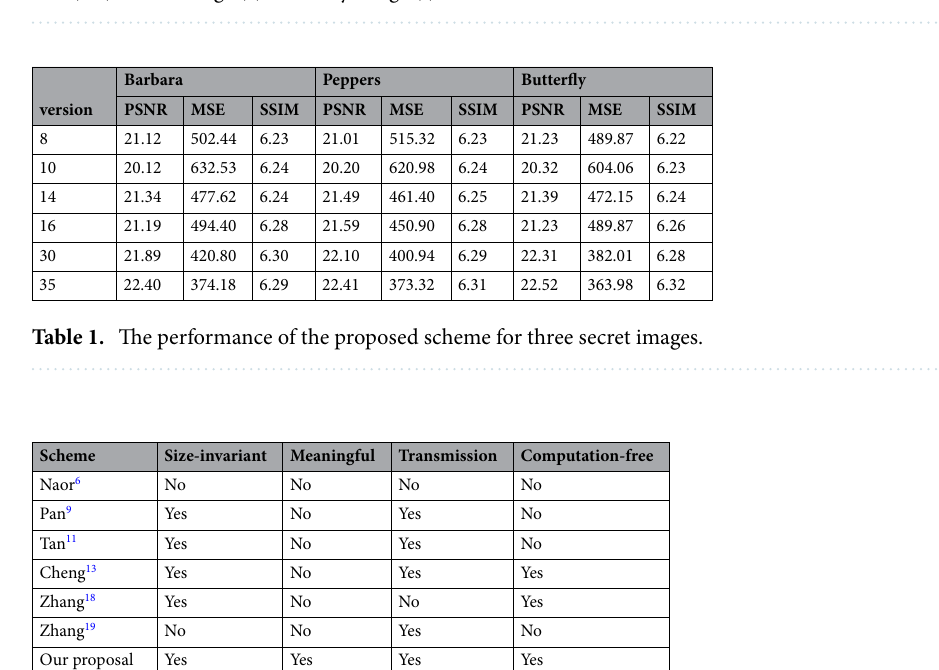
Figure 4. The experimental result of a plain text image. Cover images ( a , b ); parsed information by the zxing tool ( c , d ); secret image ( e ); recovery image ( f ).